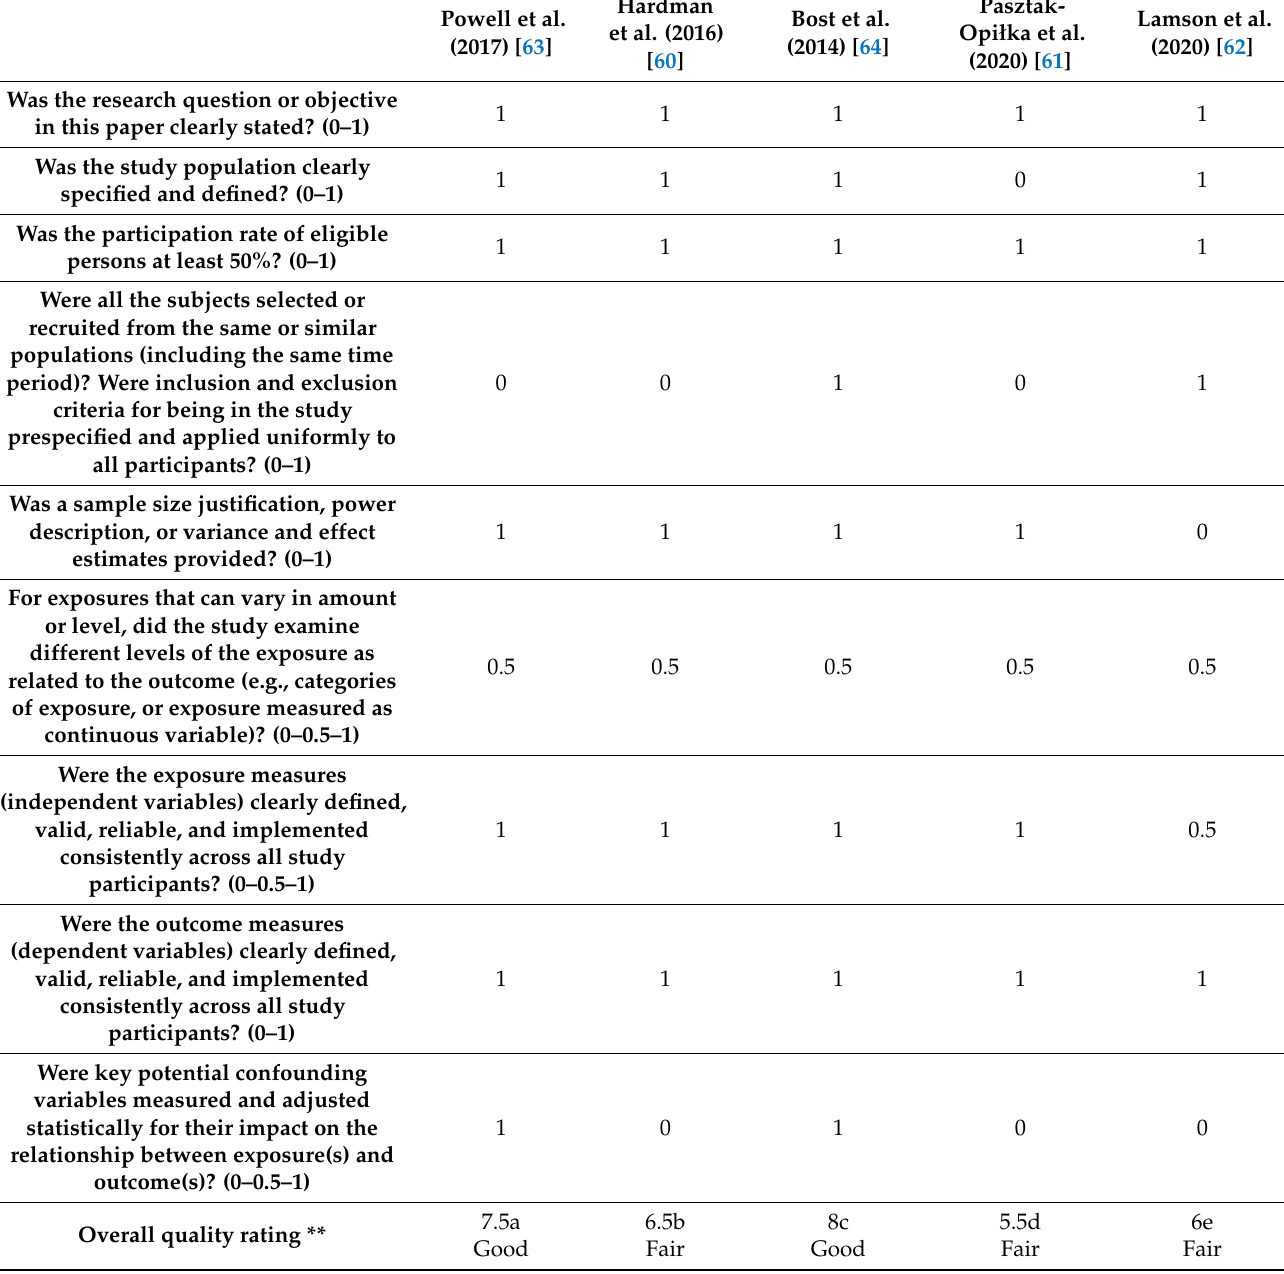
Table A2. Quality assessment of cross-sectional paper